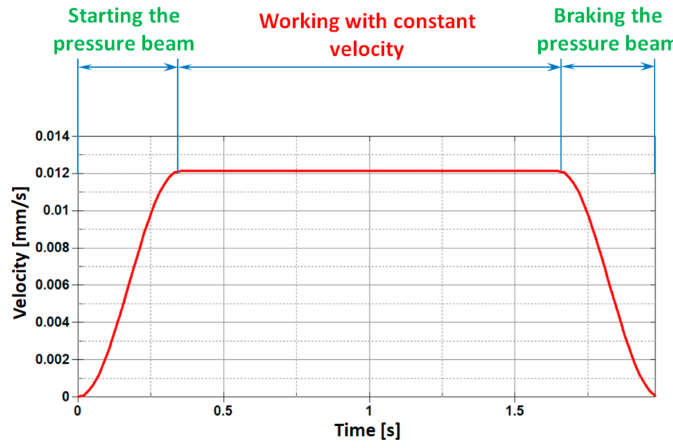
Figure 5. Individual stages of pressure beam